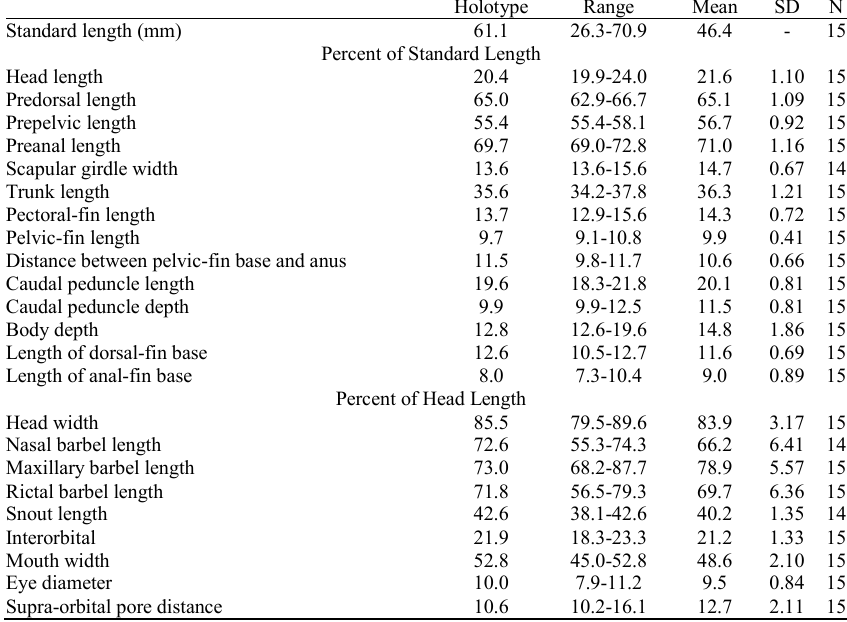
Table 4. Morphometric data for holotype and paratypes of Trichomycterus brachykechenos . SD = standard deviation; N = number of